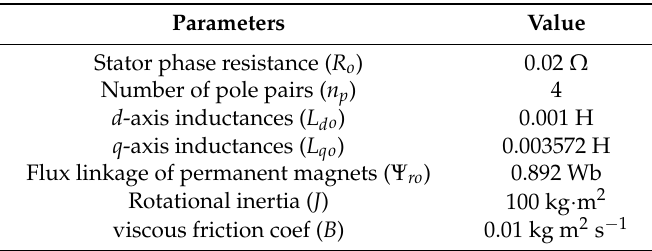
Table 1. Main parameters of PMSM.